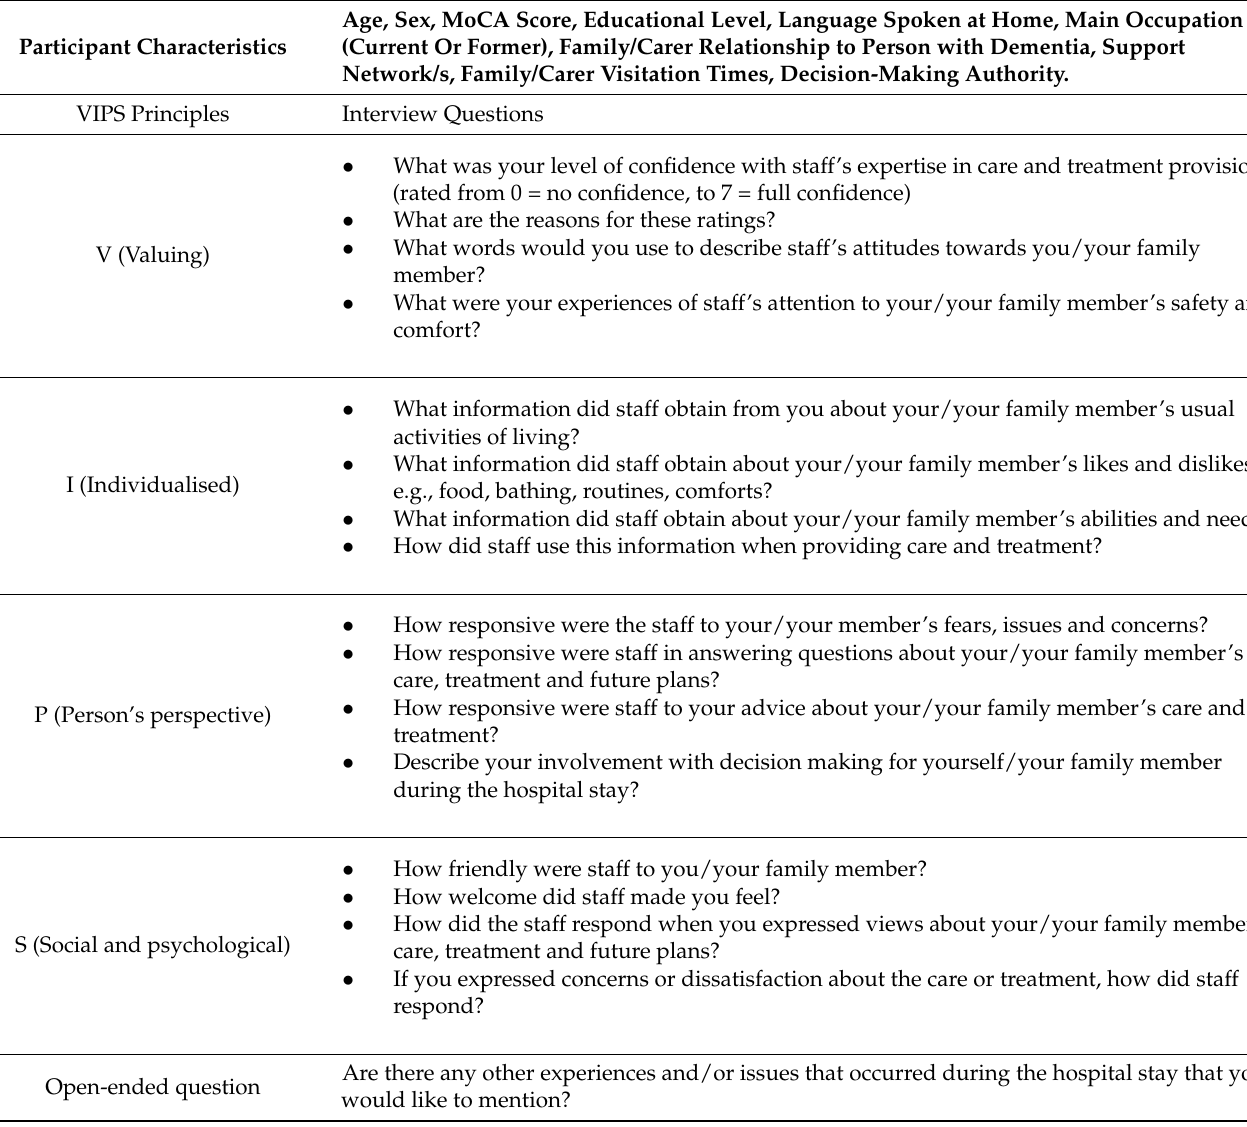
Table 1. Patient and family/carer interview